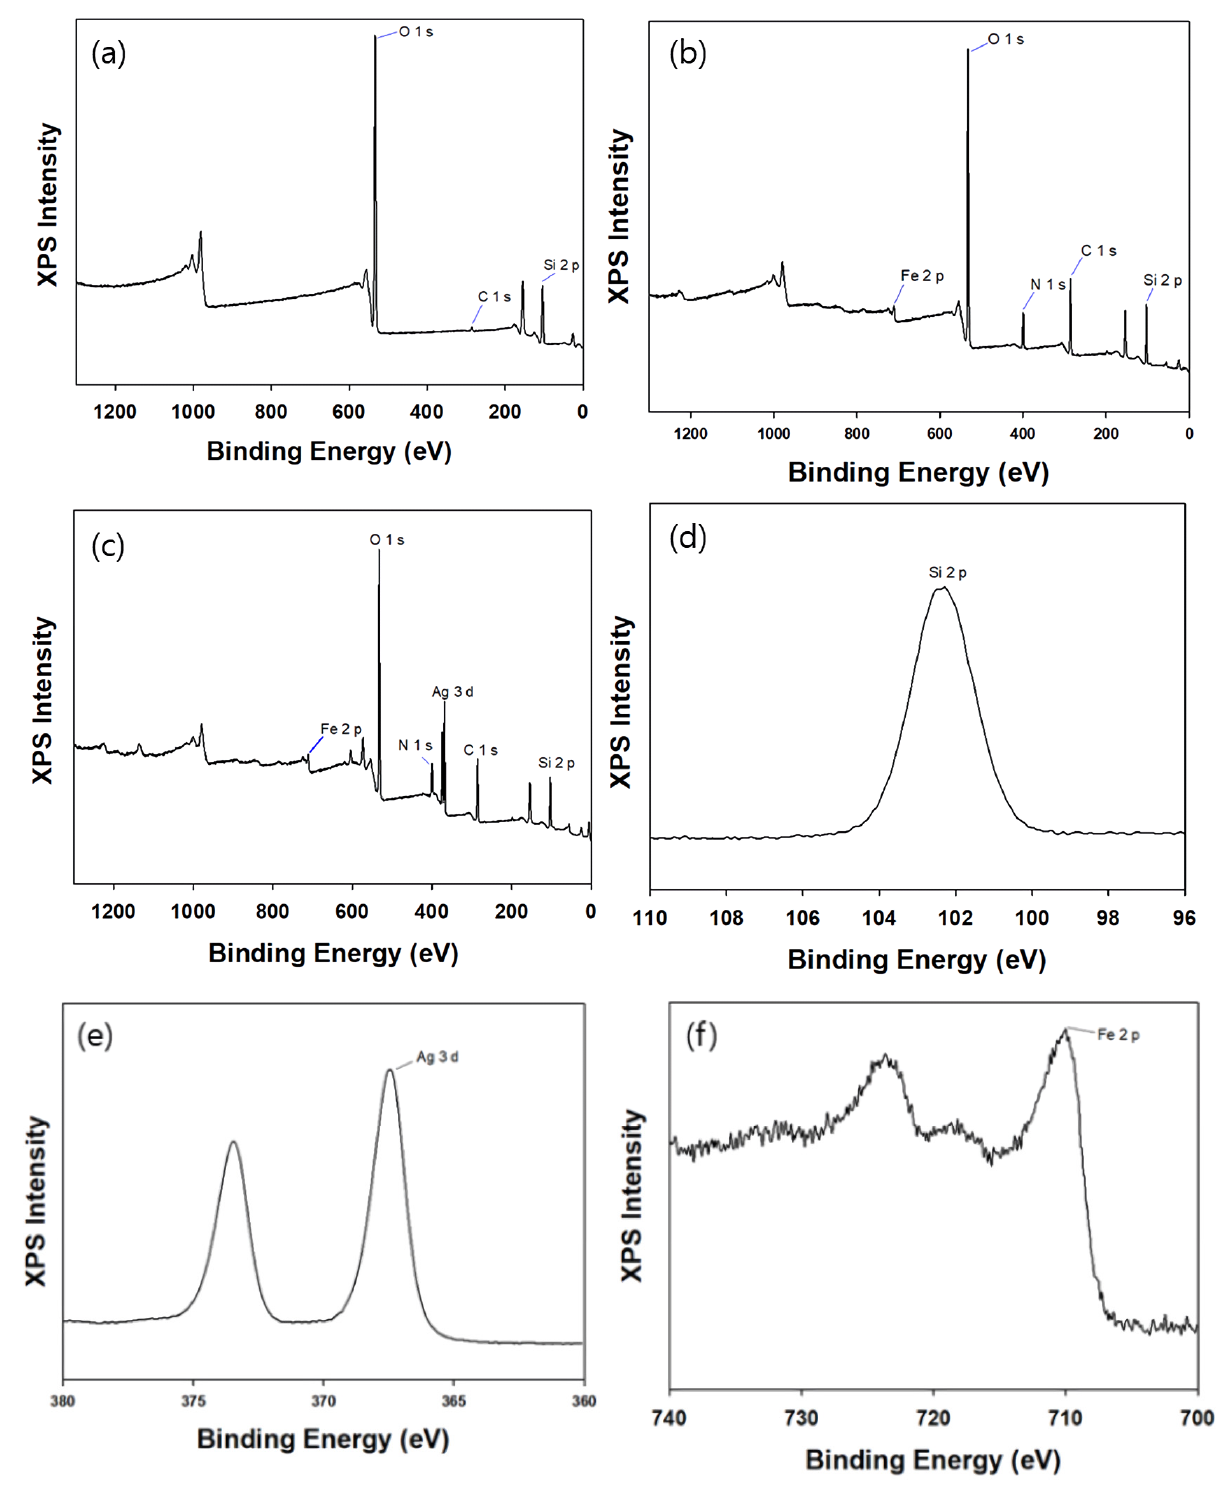
Figure 8. XPS spectra of ( a ) silica, ( b ) mag@silica, ( c ) mag@silica-Ag and ( d ) Si 2p spectrum, ( e ) Ag 3d spectrum. ( f ) Fe 2p spectrum of mag@silica-Ag.